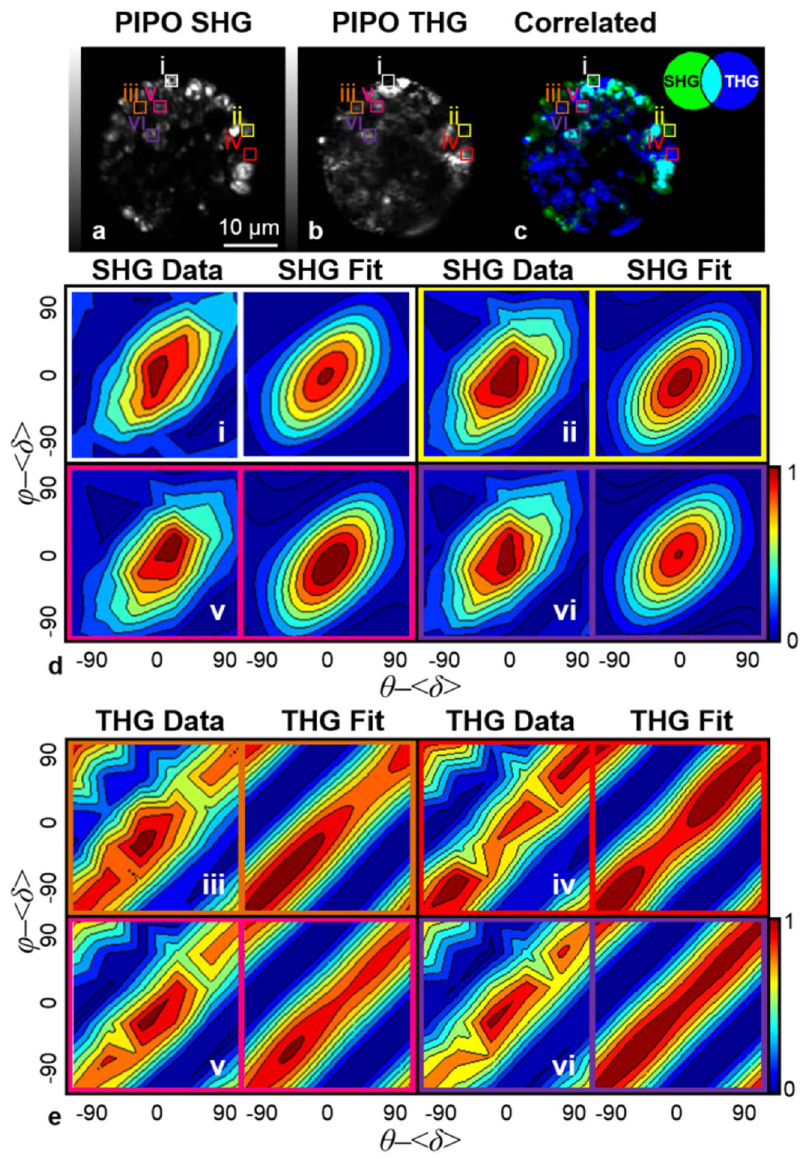
Figure 3. PIPO SHG and PIPO THG data of an aplanospore. An aplanospore visualized by (a) SHG, (b) THG, and (c) structural image cross- correlation analysis between SHG and THG [16]. The images consist of a summation of images recorded at various polarizations. Specific regions seen in (a, b, c) labeled as (i, ii, iii, iv, v, vi) were analyzed to produce (d, e) PIPO data contour plots and fits. Fitting of (a) PIPO SHG data for regions (i, ii, iii, iv, v, vi) were performed with equation (1) while fitting of (b) PIPO THG data for regions (i, ii, iii, iv, v, vi) were performed with equation (2). The contour plots shown of regions i and ii represent areas of intense SHG signal and no THG signal, regions iii and iv represent areas of intense THG signal and no SHG signal while regions v and vi represent areas of correlated SHG and THG